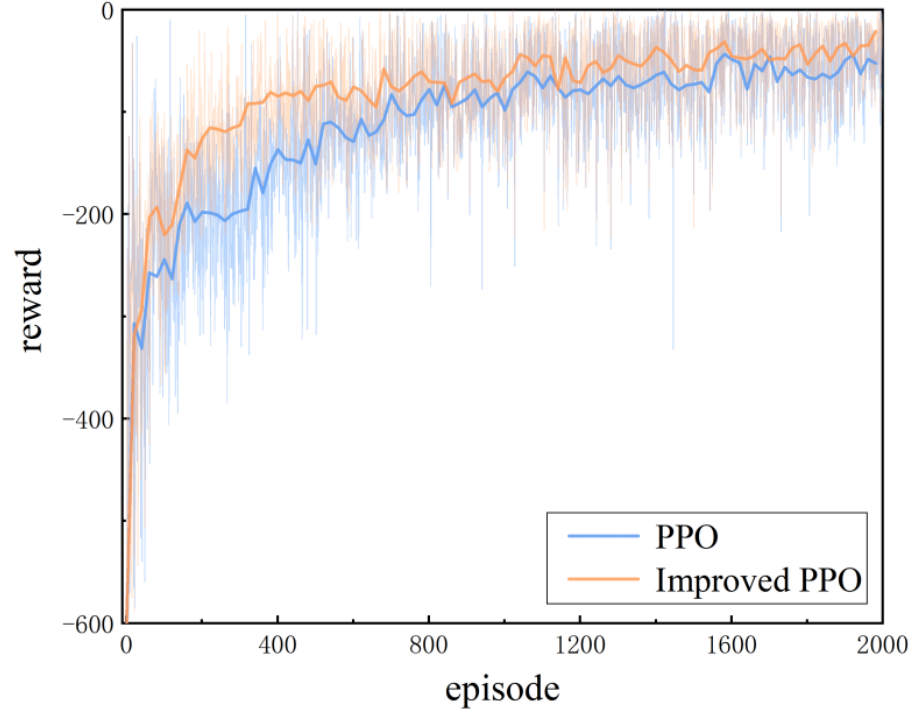
Figure 11. The relationship between the reward value of PPO and the improved PPO algorithm and the number of training